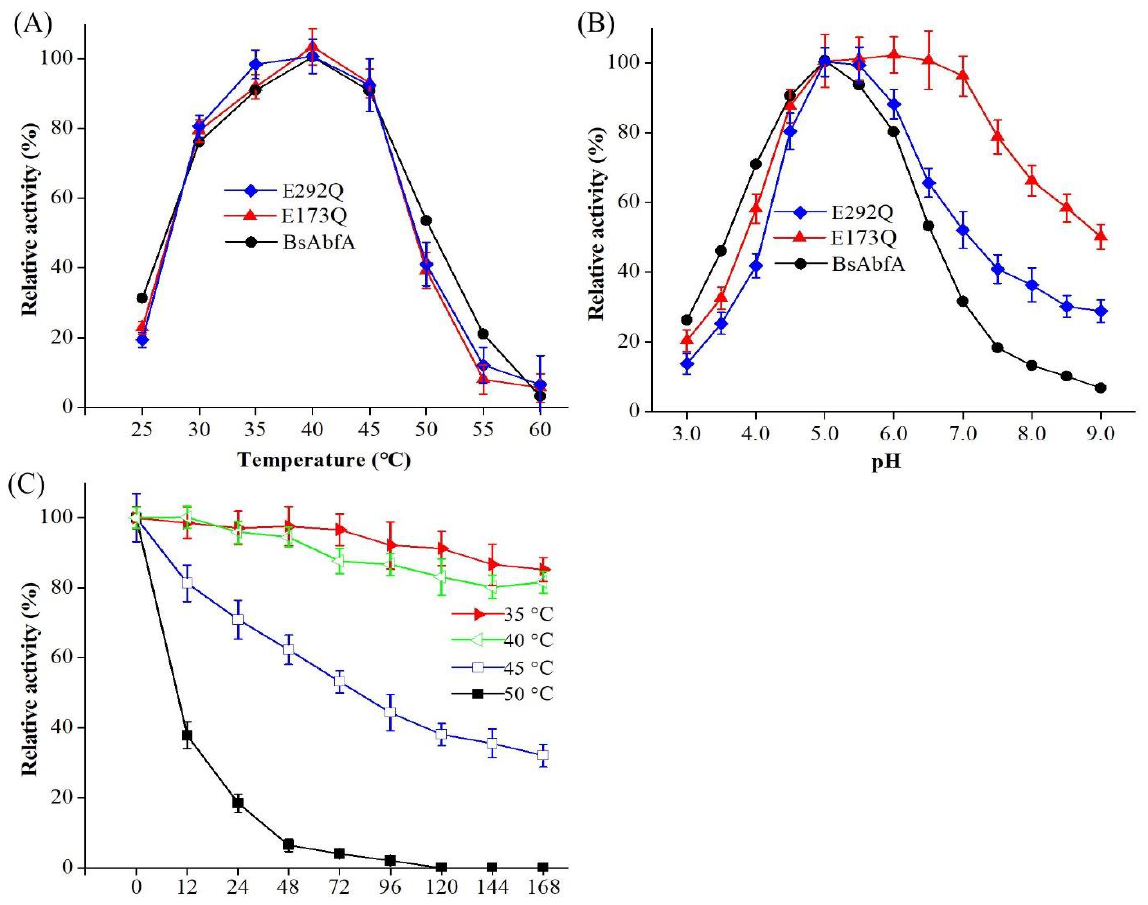
Figure 4. Temperature, pH dependence, and thermal stability of enzymatic activity of BsAbfA. ( A ) Activity measurements catalyzed by BsAbfA, E173Q, and E292Q mutants at 25‒60 °C with pH 5. ( B ) Activity measurements catalyzed by BsAbfA, E173Q, and E292Q mutant at 40 °C; the buffers in a pH range of 3‒9 were citric acid - sodium citrate (50 mM, pH 3‒6), sodium phosphate (100 mM, pH 6‒8) , and glycine-NaOH (50 mM, pH 9 – 10). ( C ) The thermal stabilities were tested at 35, 40, 45, and 50 °C, catalyzed by BsAbfA at pH 5. The maximum relative activity of each enzyme was defined as 100% using p NP- α -Af as substrate.